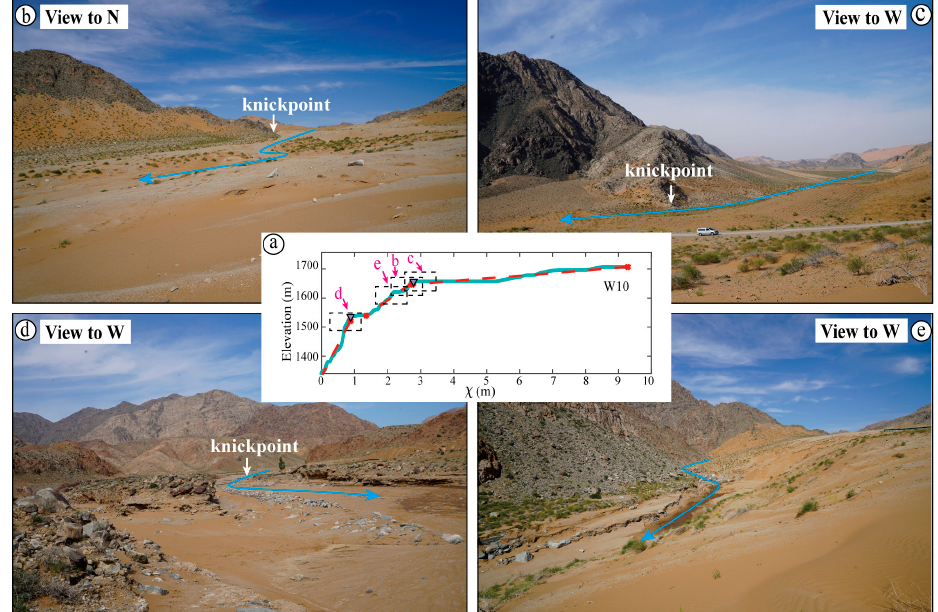
Figure 13. River longitudinal profile and field photographs of watershed 10. ( a ) Channel longitudinal profiles of watershed 10. Photographs of the river channel in the ( b ) knickpoint between the middle and upper reach, ( c ) upper reach and ( d ) knickpoint between the lower and middle reach. The black boxes and purple fonts in ( a ) represent the locations in the river channel where the photographs in ( b – e ) were taken. The blue lines and white arrows in ( b – e ) indicate the river direction and the knickpoints, respectively.